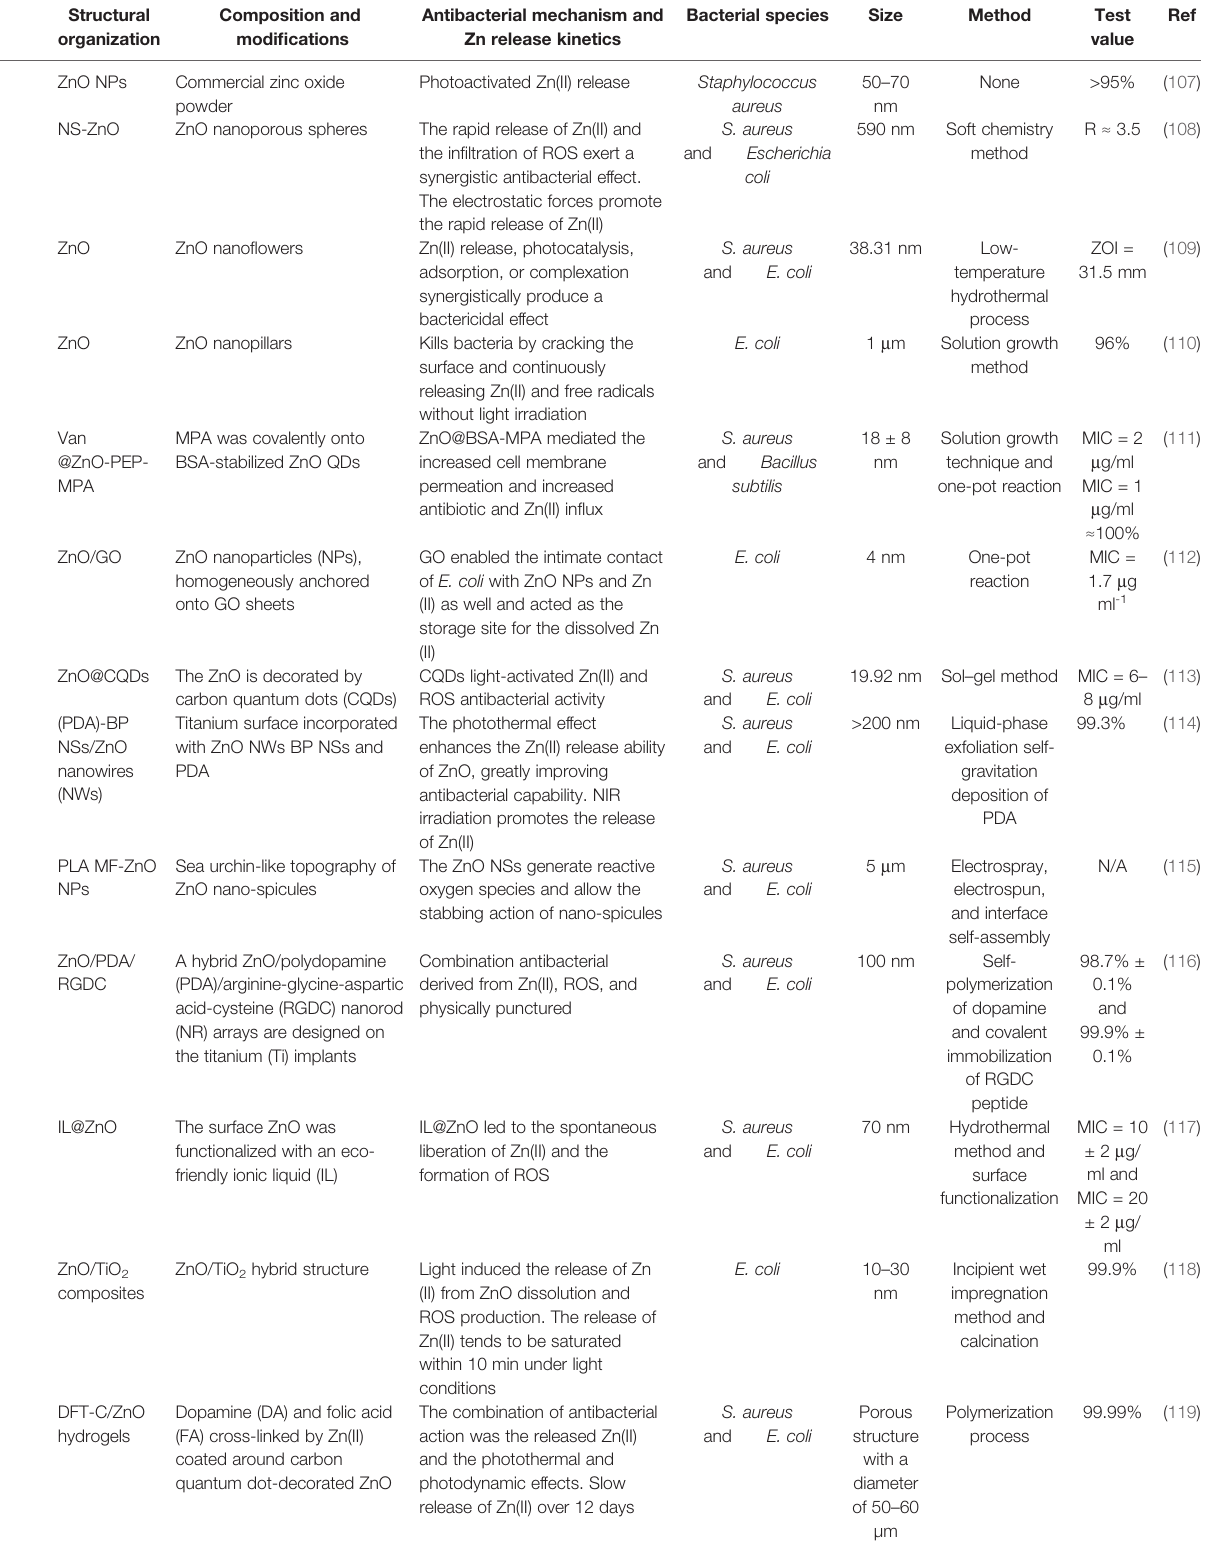
TABLE 2 | Application of antibacterial ZnO-based and other zinc-loaded nanodelivery